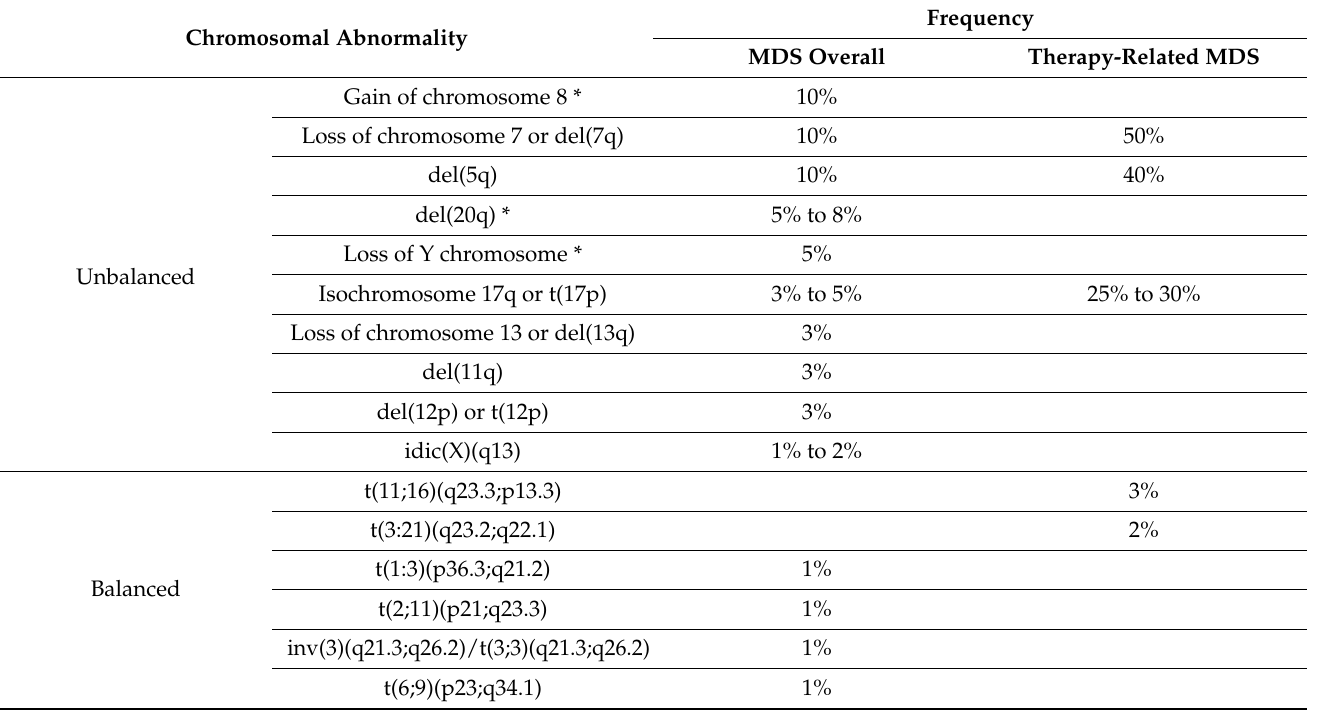
Table 3. Recurrent chromosomal abnormalities and frequencies in MDS. Adapted from Swerd- low et al.